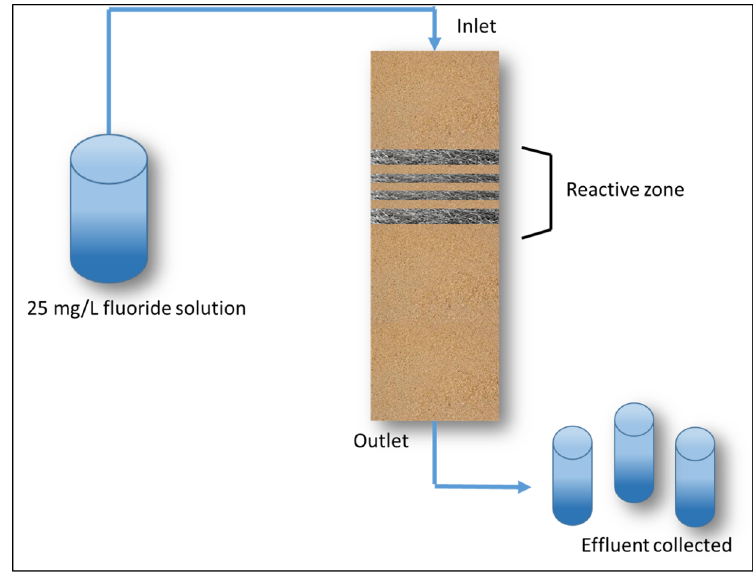
Figure 1. Graphic representation of the experimental setup of the fluoride removal experiment.